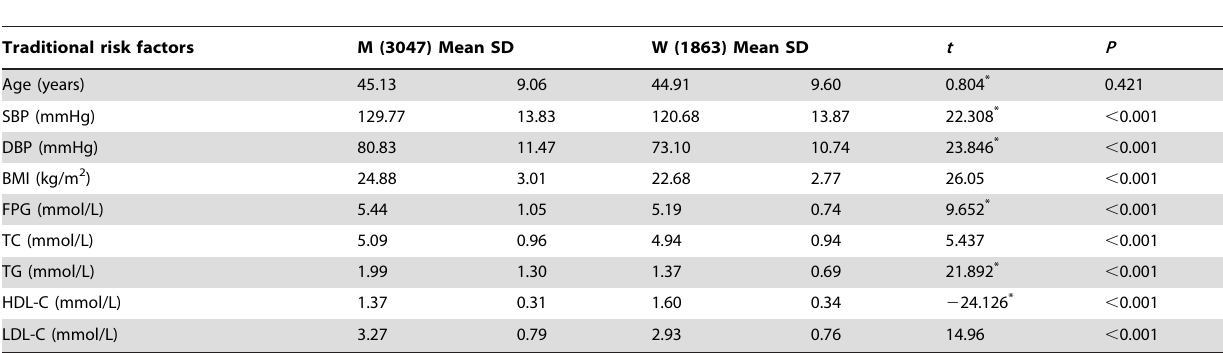
Table 1. The comparison of traditional risk factors between genders (mean 6 SD).